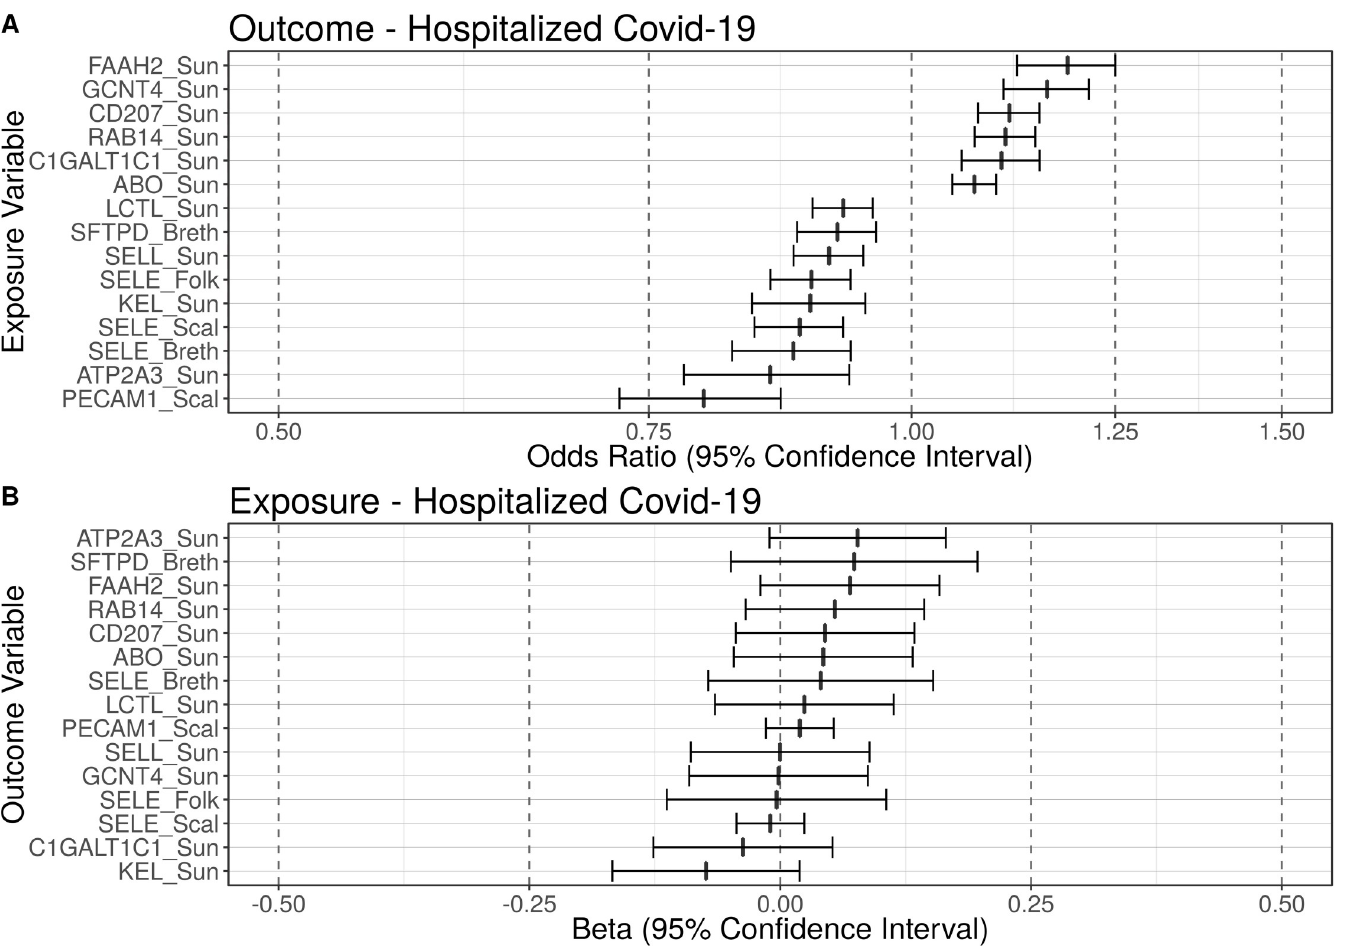
Fig 1. Blood markers putatively causally associated with hospitalized COVID-19. Summary figure of the false discovery rate-corrected (p FDR = 0.05) Mendelian randomization results using the Generalized Summary data-based Mendelian randomization (GSMR) method. Using genetic instruments and under the assumptions of Mendelian randomization, this figure displays: (A) Summary figure when hospitalization-COVID-19 is the outcome of interest; (B) Summary figure when hospitalization- COVID-19 is the exposure of interest. Odds ratios (ORs) of the blood markers causally associated with hospitalized-Covid-19 are displayed on the x-axis (with 95% confidence intervals). The blood markers are displayed on the y-axis. The dashed line at one represents an odds ratio of one (i.e., no effect). Using genetic instruments and under the assumptions of Mendelian randomization, six blood markers were causally associated with a significantly increased risk for hospitalization COVID-19 and nine blood markers were causally associated with a significantly decreased risk for hospitalization (q FDR � 0.05). ABO = ABO system transferase; ATP2A3 = ATPase sarcoplasmic/endoplasmic reticulum Ca2+ transporting 3; C1GALT1C1 = C1GALT1 specific chaperone 1; CD207 = langerin; FAAH2 = fatty acid amide hydrolase 2; GCNT4 = glucosaminyl (N-Acetyl) transferase 4; KEL = Kell metallo-endopeptidase (Kell Blood Group); LCTL = lactase-like protein; PECAM1 = platelet endothelial cell adhesion molecule; RAB14 = ras-related protein rab-14; SELE = E-selectin; SELL = L-selectin; SFTPD = surfactant protein D.